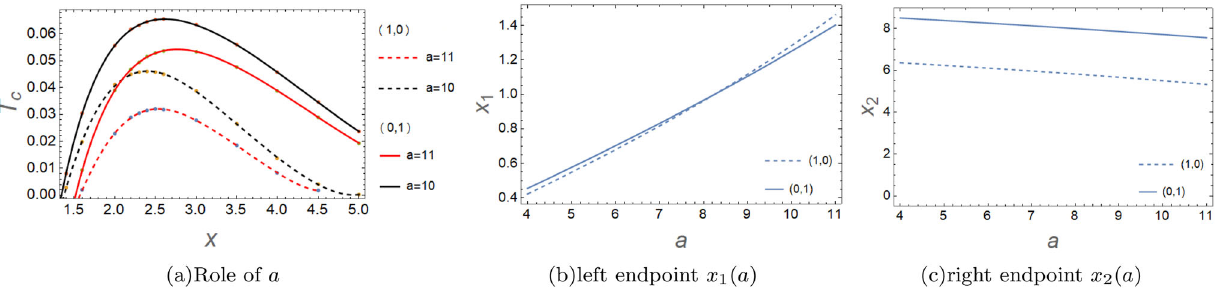
Fig. 10 Left side: the dome-shaped superconducting phase with the the coefficient a appearing in the expansion (6). Dome size increases for large Z A . Right side: the left endpoint x 1 and the right endpoint x 2